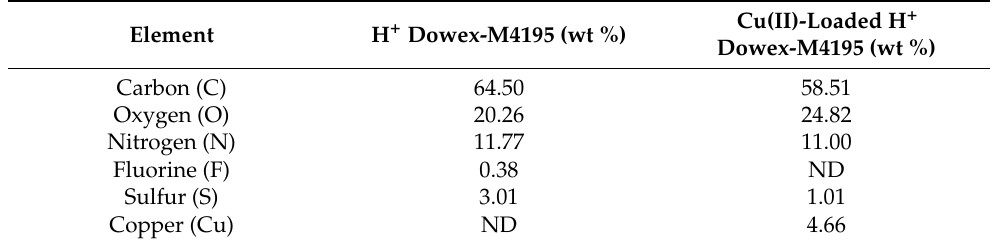
Table 1. Elemental analysis of compositions of H + Dowex-M4195 and Cu(II)-loaded H + Dowex-